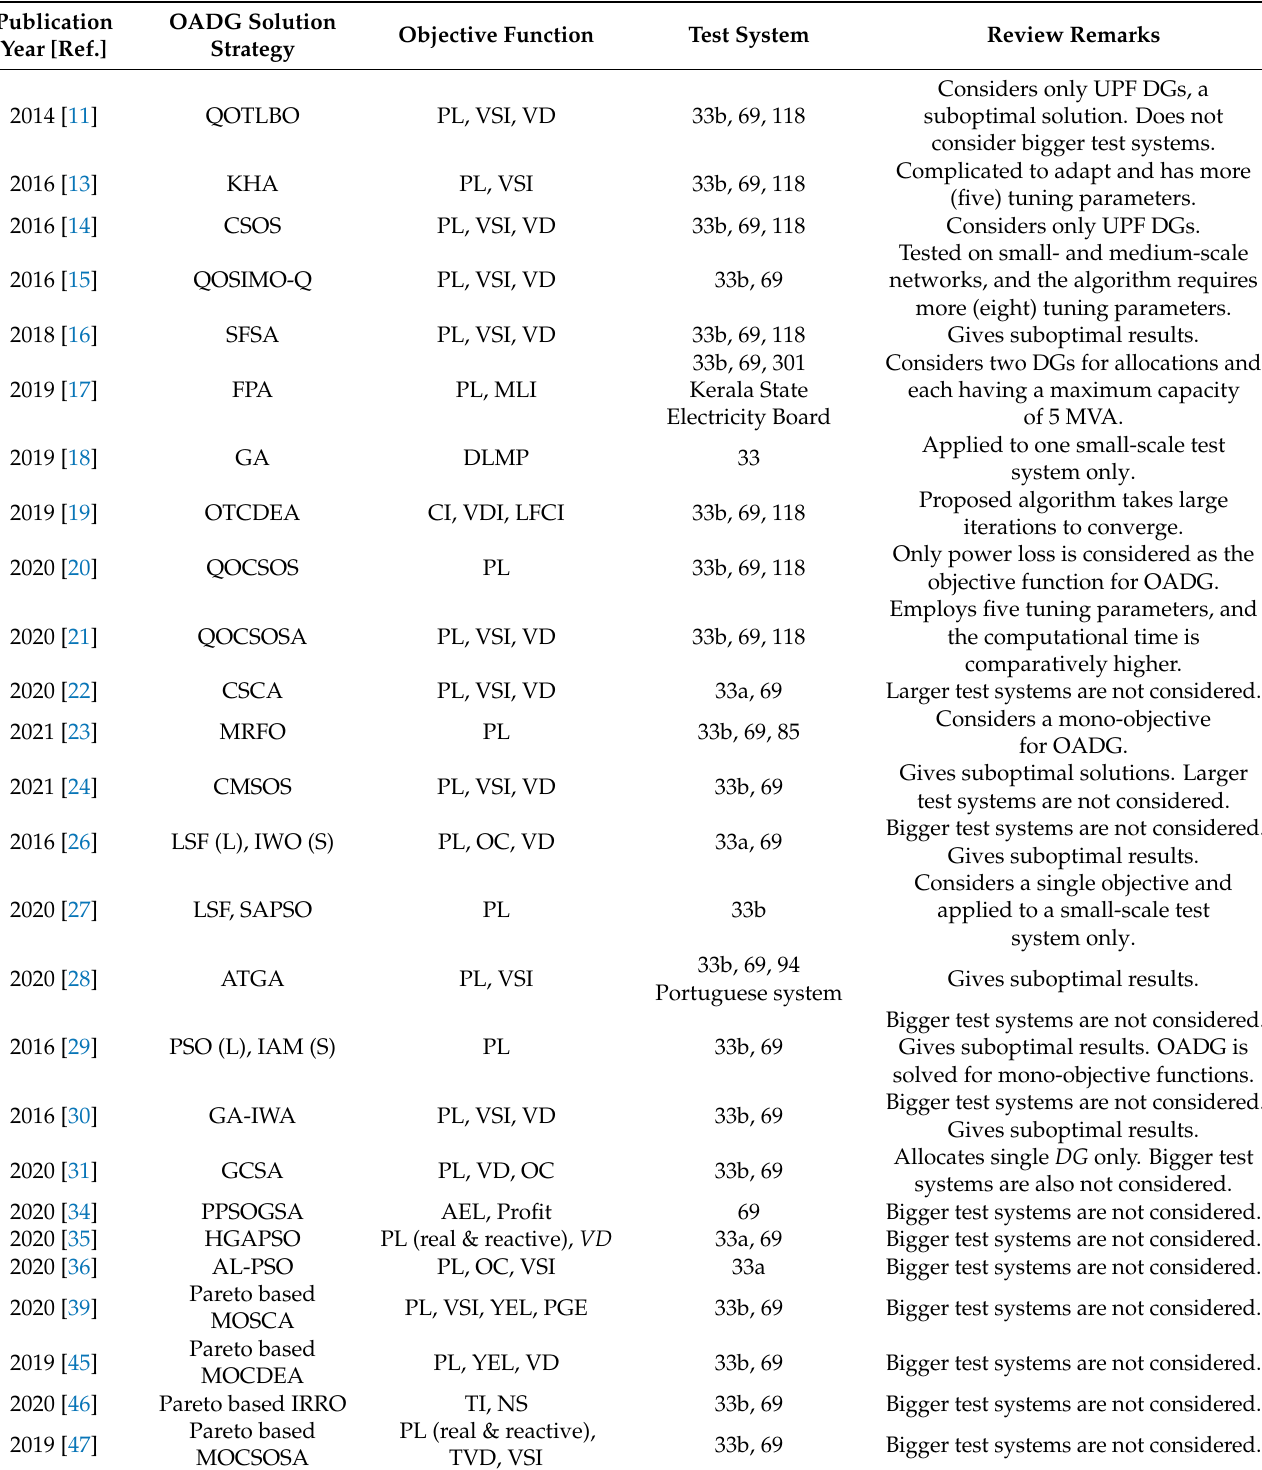
Table 1. Taxonomical review of recent OADG